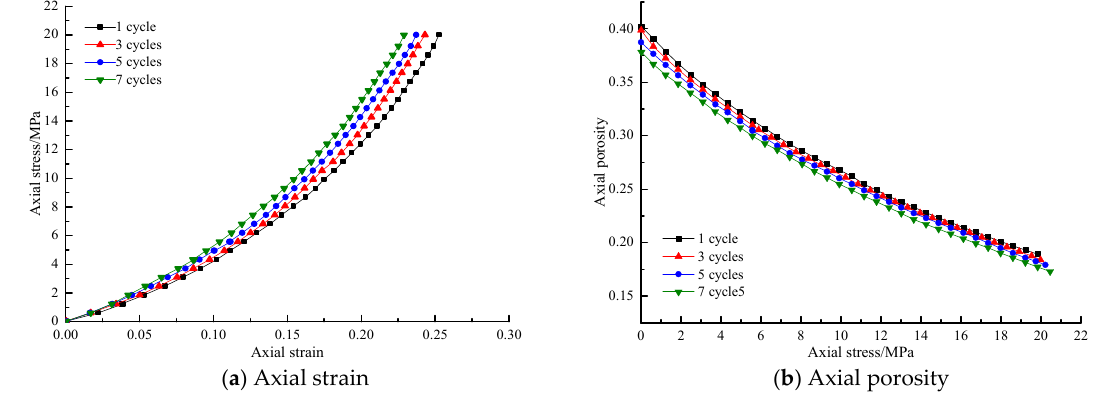
Figure 10. Changes in axial strain and porosity of samples during axial loading.